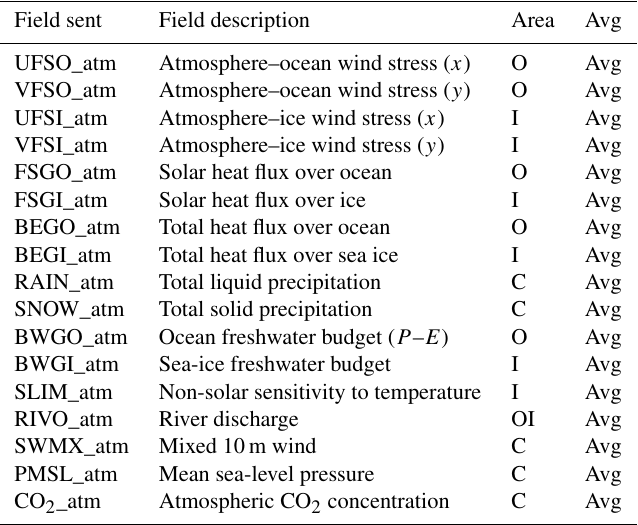
Table A4. Fields sent from CanAM to CanCPL. Descriptions are as in Table